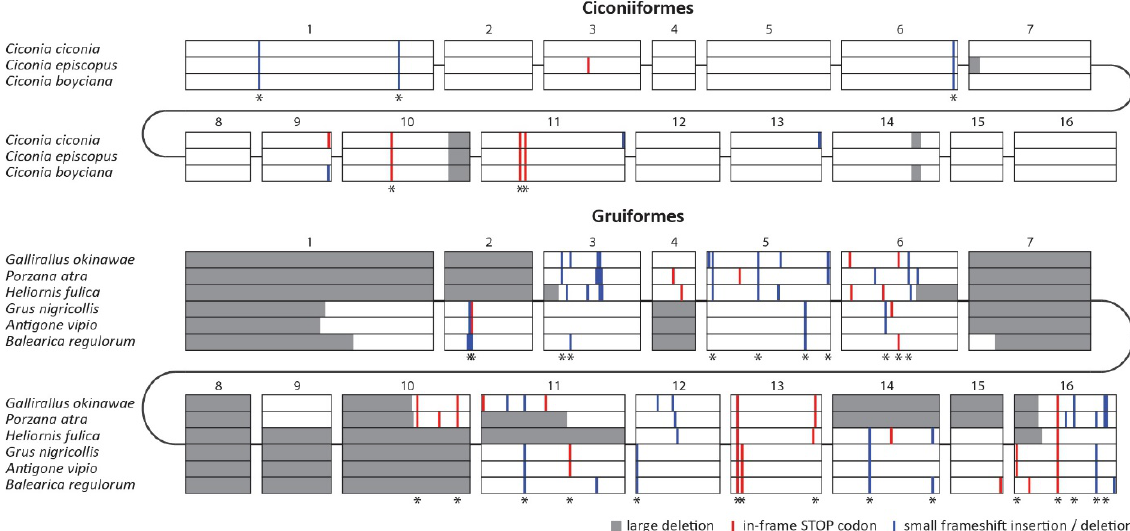
Figure 2. MDA5 pseudogenization in the clades of Ciconiiformes and Gruiformes. Aligned MDA5 coding sequences of all MDA5 -disrupted species are shown schematically, separately for each order. Exons are represented in scale by open boxes. The predicted inactivating mutations are visualized as described in the figure legend. Mutations shared by at least two species within each order are marked by an asterisk.